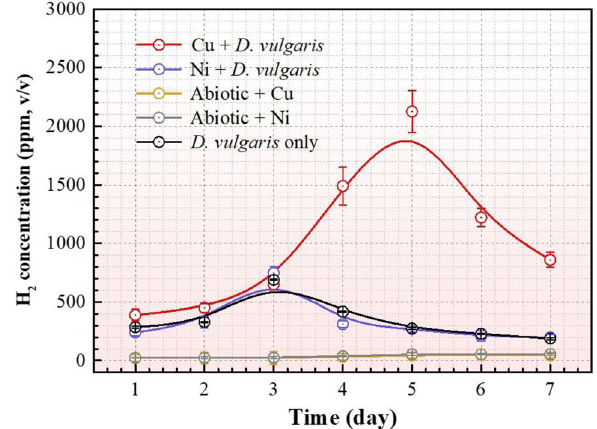
Fig. 3 Headspace H 2 concentration. Headspace H 2 concentration of the 75 mL headspace in anaerobic vials (Cu + D. vulgaris , Ni + D. vulgaris , Cu + Abiotic, Ni + Abiotic, and D. vulgaris only) during the 7-d incubation (Error bars stand for the standard deviations from at least three independent coupons).